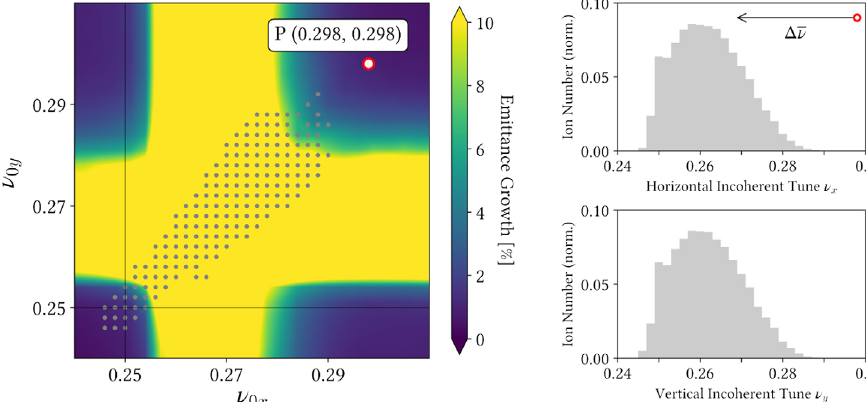
FIG. 20. Example of the incoherent tune spread of a Gaussian beam with η ¼ 0 . 9 . The emittance growth is evaluated from W ARP simulations that have assumed the same numerical conditions as in Fig. 3 except for the transport distance extended to 200 AG periods here. Gray dots represent the approximate incoherent tunes of individual particles when the operating point is set at ð ν 0 x ; ν 0 y Þ ¼ ð 0 . 298 ; 0 . 298 Þ where the matched Gaussian beam is completely stable. The right panels show the particle-number histograms plotted as a function of the incoherent tunes ν x and ν y . The ordinate (the number of particles) has been normalized with the total number of macroparticles used for the PIC simulation. The arrow in the upper right panel indicates the size of the rms tune